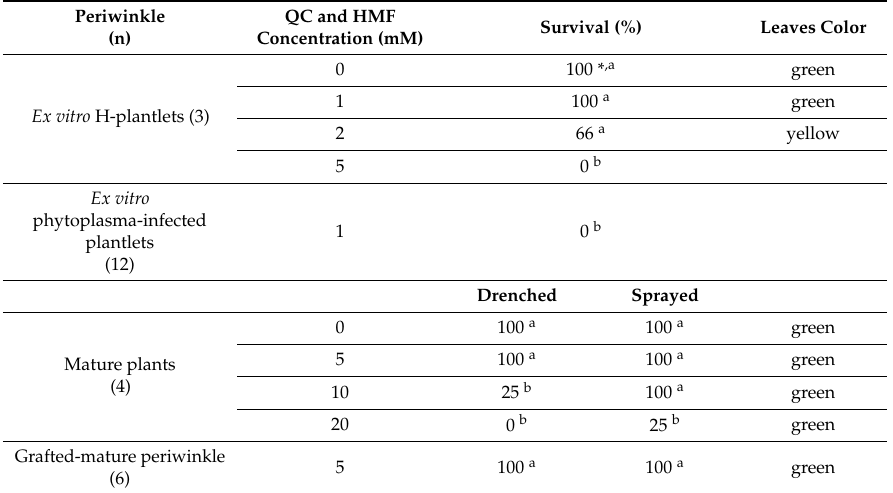
Table 2. Phytotoxicity: Periwinkle survival rates as affected by 4 ‐ quinolinecarboxaldehyde (QC) and 5 ‐ hydroxymethyl ‐ 2 ‐ furaldehyde (HMF) application. Ex vitro plantlets were submerged in the solution for 24 h before planting, while mature plants were drenched or sprayed. Survival rates were examined a week post ‐ treatment.